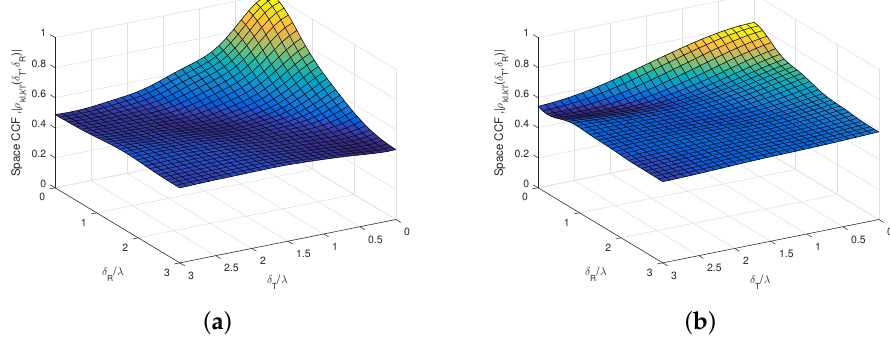
Figure 12. SCCF of SRT and without ceiling for NLoS scenario ( c R = 1 ) . ( a ) SCCF of SRT. ( b ) SCCF of SRT without